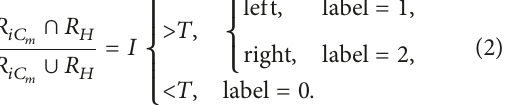
Figure 4: Detected eye regions, region centers, and actual eye centers. The yellow cross represents the center of the eye region and the red cross is the actual center of the eye. Table 1: The percentage of images with at least one effective feature point versus the parameter 𝑁